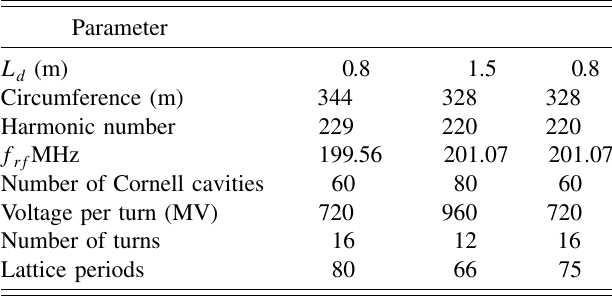
TABLE III. Parameters for the rf simulations.